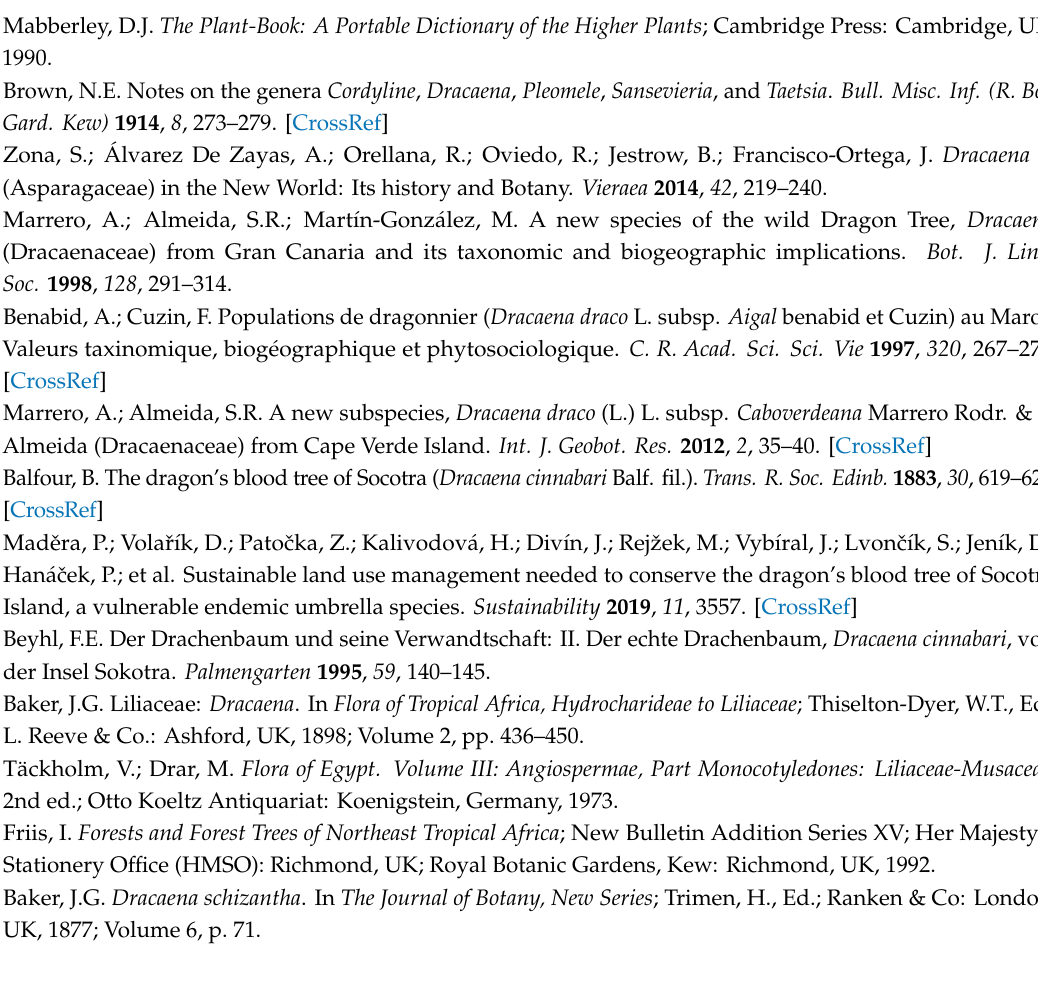
Table S1: Metrics of growth habit of all modeled trees; Figure S1: Comparison of metrics of growth habit. Author Contributions: Study design, fieldwork, data analysis, and writing the article: P.V. and P.M.; data analysis and writing the article: K.D., S.L., L.V., and M.Š.; data analysis and field work: Z.P., A.P., M.B., L.E., K.L., and H.K. All authors have read and agreed to the published version of the manuscript. Funding: This research has been financially supported by the Internal Grant Agency of Mendel University in Brno, Czech Republic (project No. IGA VT